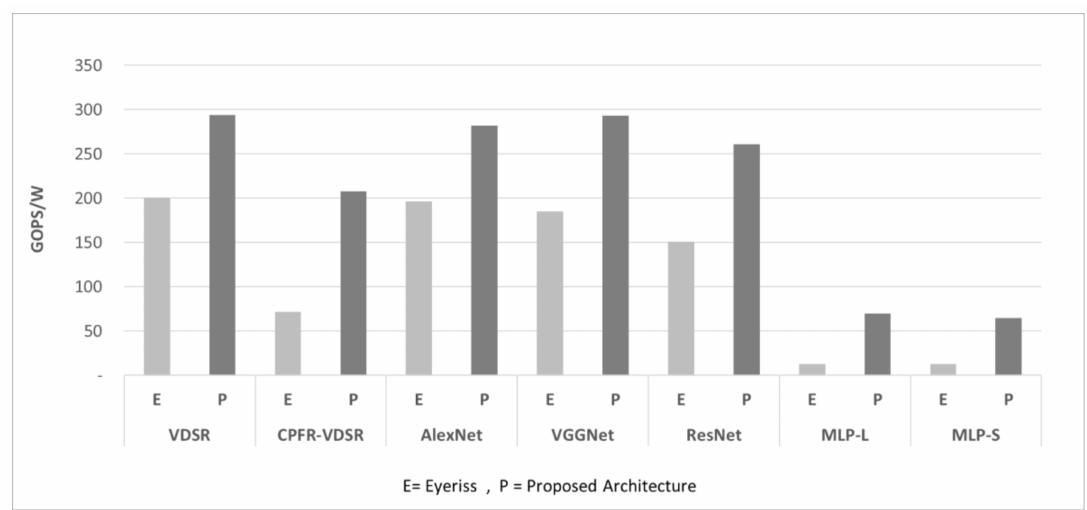
Figure 8. Comparison of efficiency (GOPs/W) between the proposed architecture and